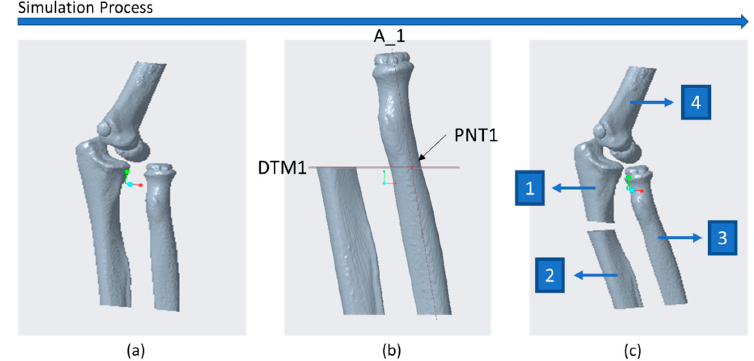
Figure 5. Simulation process: ( a ) the reconstructed 3D model is prepared for simulation through the definition of geometrical references; ( b ) the cutting plane DTM1 meets the axis A_1 defining the rotation point PNT1. DTM1 represents the plane passing through the cutting plane and A_1 is the central axis of a cylinder built on the two bases of the bone; ( c ) the result of the simulation shows the final position of all 4 pieces (1: proximal part of the ulna; 2: distal part of the ulna; 3: radius; 4: humerus).